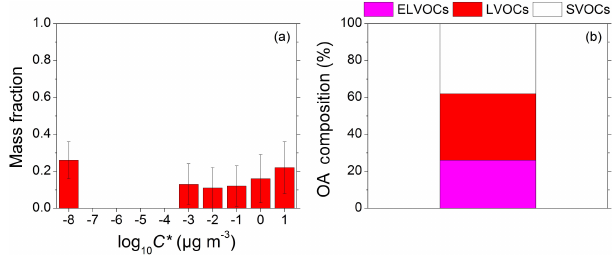
Figure 2. (a) Total organic aerosol (OA) volatility distribution along with its uncertainty estimated by the Karnezi et al. (2014) approach. The error bars represent the corresponding variability ( ± 1 standard deviation). (b) OA composition. Magenta represents the extremely low volatility organic compounds (ELVOCs), red the low volatility organic compounds (LVOCs), and white the semivolatile organic compounds